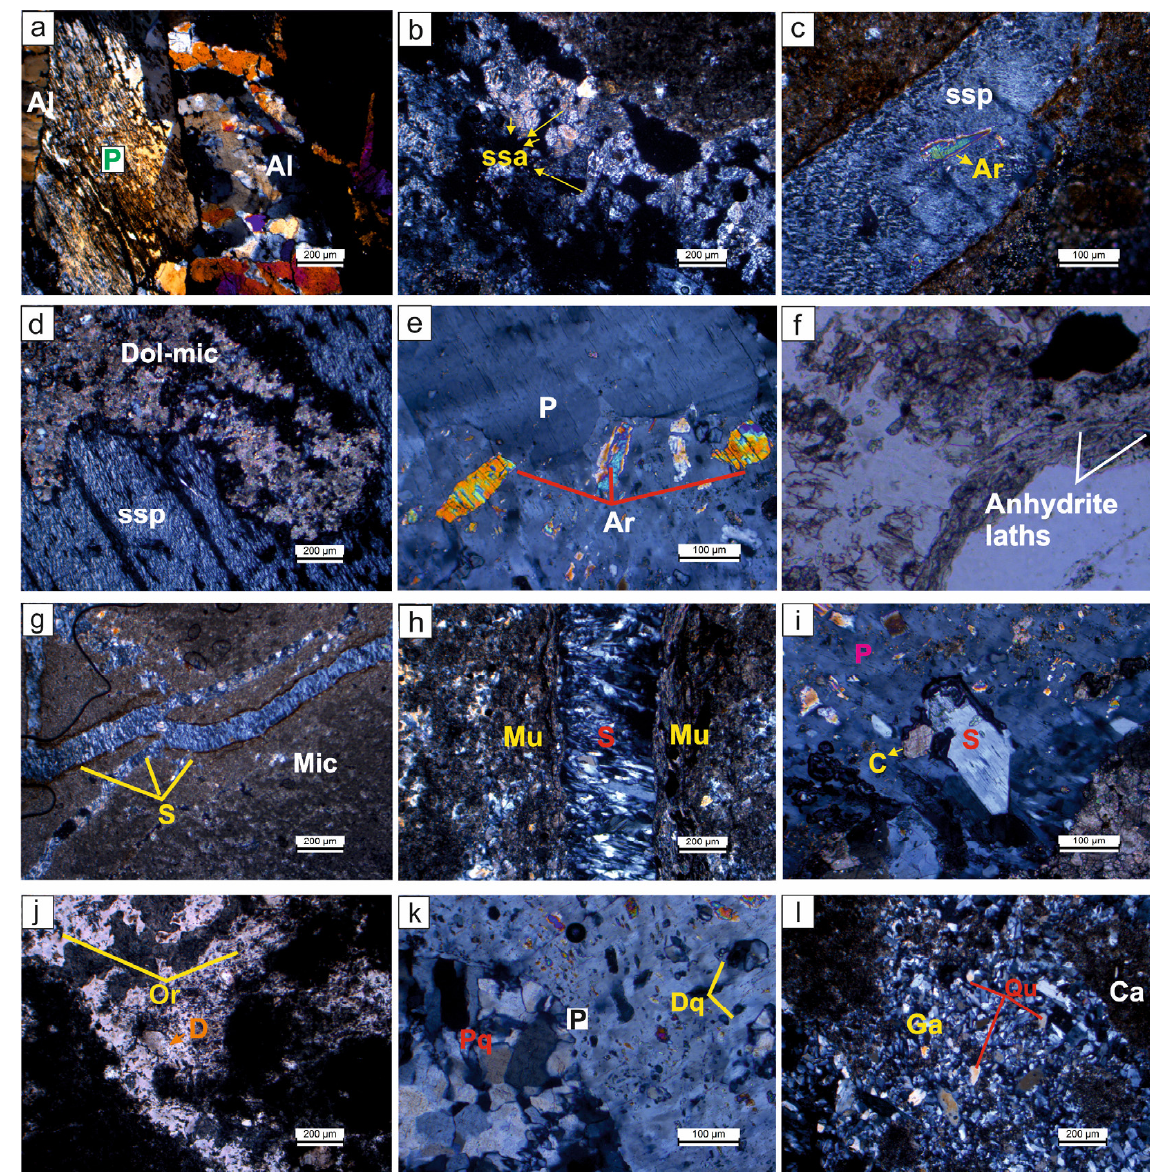
Figure 4. Petrographic images of the evaporitic rock samples. ( a ) Alabastrine (Al) textured secondary gypsum replacing porphyroblastic (P) gypsum texture (OBK-6-Gönen); ( b ) spindle-shaped acicular (ssa) crystalline textured secondary gypsums (OBK-18-Gönen sample); ( c , d ) (ssp) and anhydrite relict (Ar), a speci fi c orientation and carbonation (dolomicritic textured) (K-10 Köprüa ğ z ı ); ( e ) subhedral-anhedral anhydrite grains in (P) (OBK-21-Gönen); ( f ) primary anhydrite laths within the dolomitic mud (Plane light) (K-4 Köprüa ğ z ı ); ( g ) satin-spar gypsum (S) fi lling cracks within the mi- critic carbonate (Mic) (B-10 Örencik); ( h ) muscovite minerals (Mu) observed along the (S) veinlets (K-4 Köprüa ğ z ı ); ( i ) subhedral and euhedral secondary calcite minerals (C) replacing tabular gyp- sum (Tg) and (P) (OBK-21 Gönen); ( j ) organic ma tt er relicts (Or) and rhombohedral dolomite (D) (Plane light) (OBK-18 Gönen); ( k ) detritic (Dq) and polycrystalline quar tz (Pq) grains within the (P) (OBK-21 Gönen); ( l ) gypsarenite (Ga), the cavities of which are fi lled with quar tz (Qu) grains and carbonates (Ca) (OBK-18 Gönen).